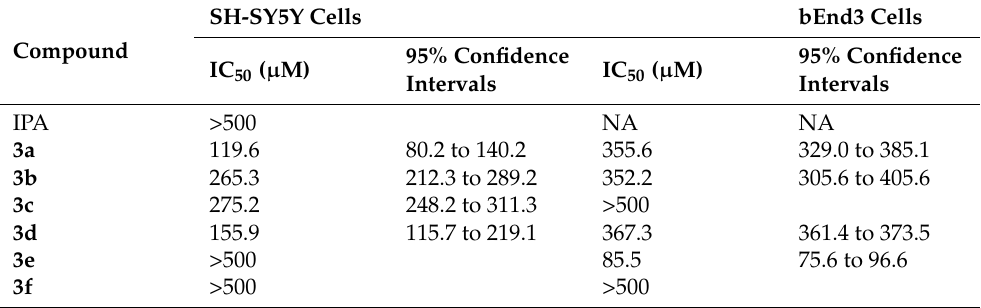
Figure 1. Hemolytic e ff ects of ( a ) IPA and compounds 3a–f ; ( b ) compounds 5a–f ; on human erythrocytes. The results are expressed as means ± SD of triplicate assays (n = 3). All groups were compared statistically vs. untreated controls by one-way ANOVA with Dunnet’s post hoc test *** p < 0.001 vs. control. Table 1. In vitro cytotoxicity of new benzimidazole derivatives 3a–f and 5a–f (IC 50 values) on SH- SY5Y and bEnd3